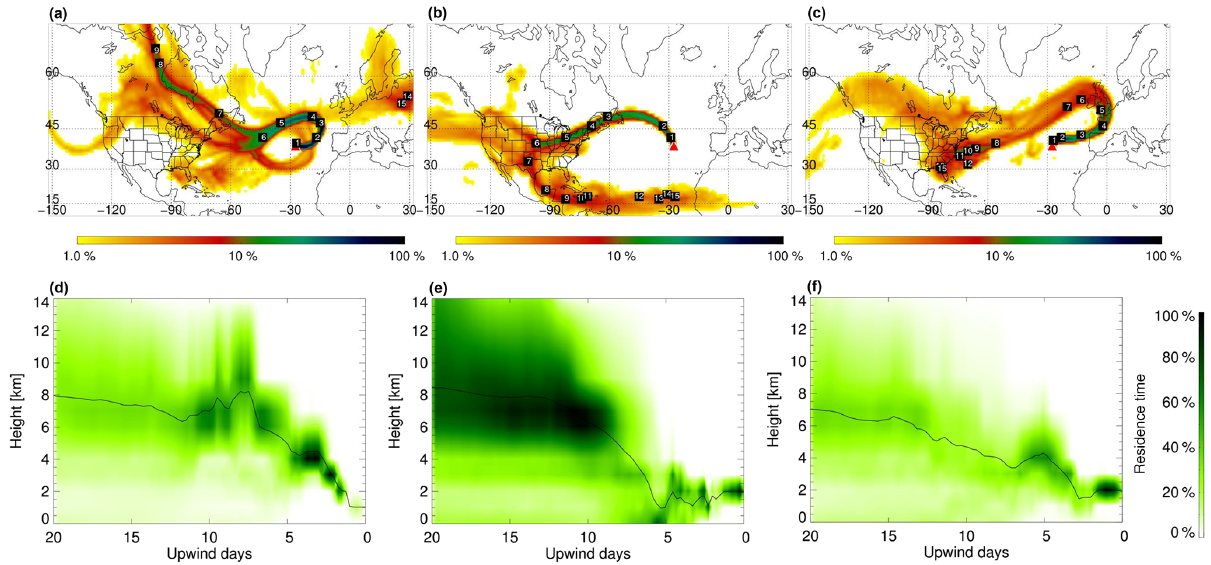
Figure 1. FLEXPART retroplumes for 28 June 2013 06:00LT (PMO-1, a, d ), 6 July 2014 03:00LT (PMO-2, b, e ), and 21 June 2015 03:00LT (PMO-3, c, f ): column-integrated residence time over the 20-day transport time (a–c) and vertical distribution of the retroplume residence time at given upwind times (d–f) . The labels indicate the approximate locations of the center of the plume for each of the transport days. Residence time is color coded by logarithmic grades representing its ratio to the location of maximal integrated residence time (100%). The black lines in (d) – (f) indicate the mean height of the plume during transport. Table 1. Average concentrations (µgm − 3 ) of major ions and organic